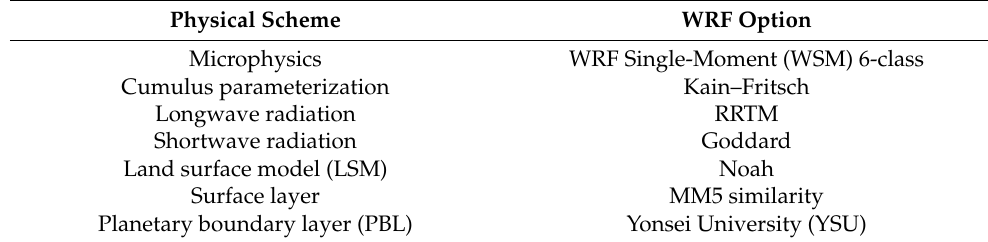
Table 2. Physical schemes for WRF